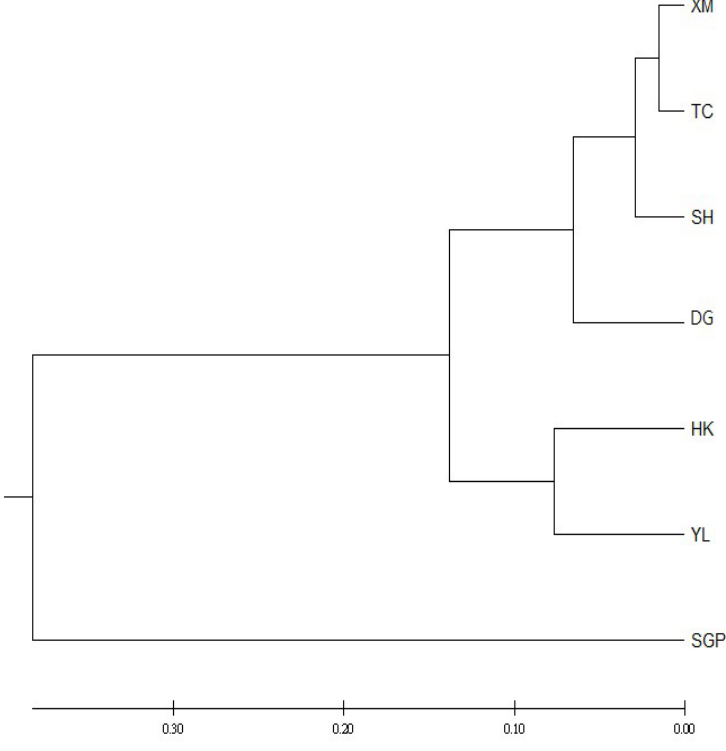
Figure 4. The relationships between seven sampling sites are shown in an UPGMA tree. It is possible to further divide the first group into two subgroups. One of the subgroups Table 2. The matrices shown below show pairwise F ST (below diagonal) and p values (above di- of the first group included the XM, TC, SH and DG populations; the second subgroup agonal) for seven populations of P. sanguinolentus in East Asia. included the HK and YL populations. According to the UPGMA trees, five different groupings could be detected among the seven populations listed in Table 3. Based on the AMOVA analysis, the F ST for seven pair-wise population was 0.4259, indicating significant heterogeneity in at least one case. Significant values of Φ CT were observed in all